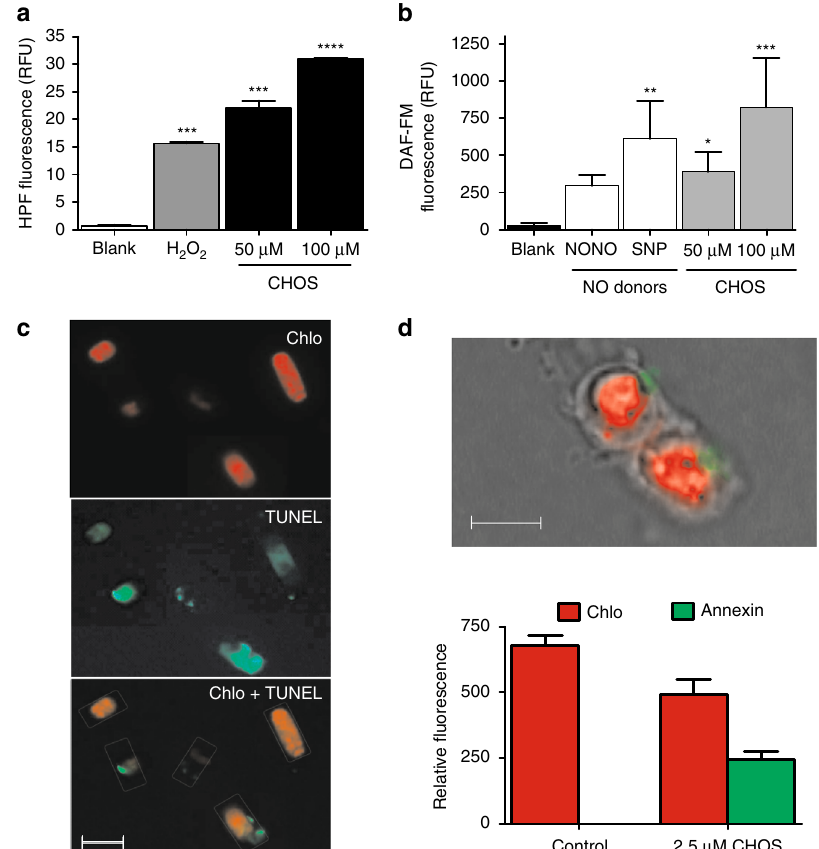
Fig. 5 Sterol sulfates trigger oxidative burst and programmed cell death (PCD) mechanisms in S. marinoi . a Production of hROS by exposure of diatom healthy cells to lethal concentrations (50 and 100 μ M) of CHOS for 2 h. Activity was determined by the hydroxyphenyl fl uorescein (HPF) assay. Data ( n = 6) are reported as relative fl uorescence units (RFU) ± s.d. H 2 O 2 (200 µ M) was used as positive control. Blank = untreated cells; *** P < 0.001, **** P < 0.0001 (one-way ANOVA of treated cells vs blank); b Production of nitric oxide (NO) by exposure of diatom healthy cells to lethal concentrations (50 and 100 μ M) of CHOS for 4 h. Activity was determined by 4-amino-5-methylamino-2 ′ ,7 ′ -di fl uorescein diacetate (DAF-FM). Data ( n = 6) are reported as relative fl uorescence units (RFU) ± s.d. The NO donors diethylamine nitric oxide (NONOate) and sodium nitroprusside (SNP) were used as positive control. Blank = untreated cells; * P < 0.05, ** P < 0.01, *** P < 0.001 (one-way ANOVA of treated cells vs. blank); c DNA fragmentation assessed by TUNEL assay after 24 h application of 2.5 µ M CHOS. View under the fl uorescence microscope by using 515/565 band fi lter for the green fl uorescence and a LP615 band fi lters for only red fl uorescence emission. Chlorophyll auto fl uorescence is represented in red (above), fl uorescein (TUNEL) in green (middle), merged green and red signal (below). d Phosphatidylserine externalization assessed by Annexin V after 24 h application of 2.5 µ M CHOS. Composed picture of S. marinoi cells under the fl uorescence microscope at ×1000 magni fi cation by oil-immersion lens and quanti fi cation of the red fl uorescence due to chlorophyll and the green fl uorescence due to FITC bound to Annexin V. GFP Images were analyzed by ImageJ and normalized to gray value. Data ( n = 9) are reported as relative fl uorescence units (RFU) ± s.d. Control = untreated cells; Scale bars depict 10 µ